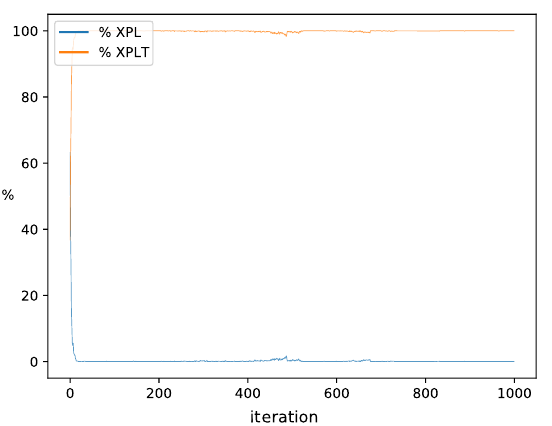
Figure 12. SCA—Exploration and Exploitation Graphic of instance c5 version BCL1.